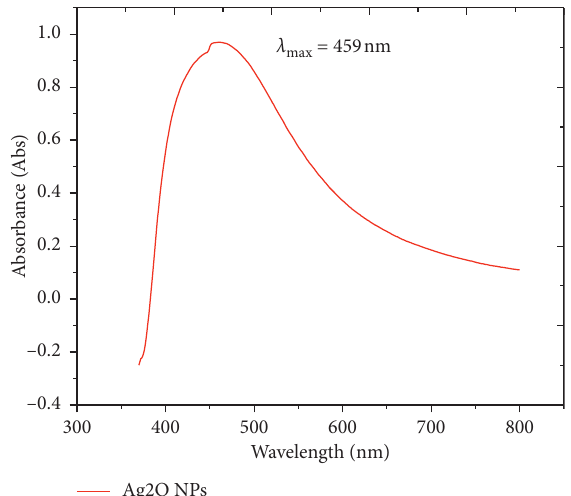
Figure 2: UV-Vis adsorption spectra of Ag